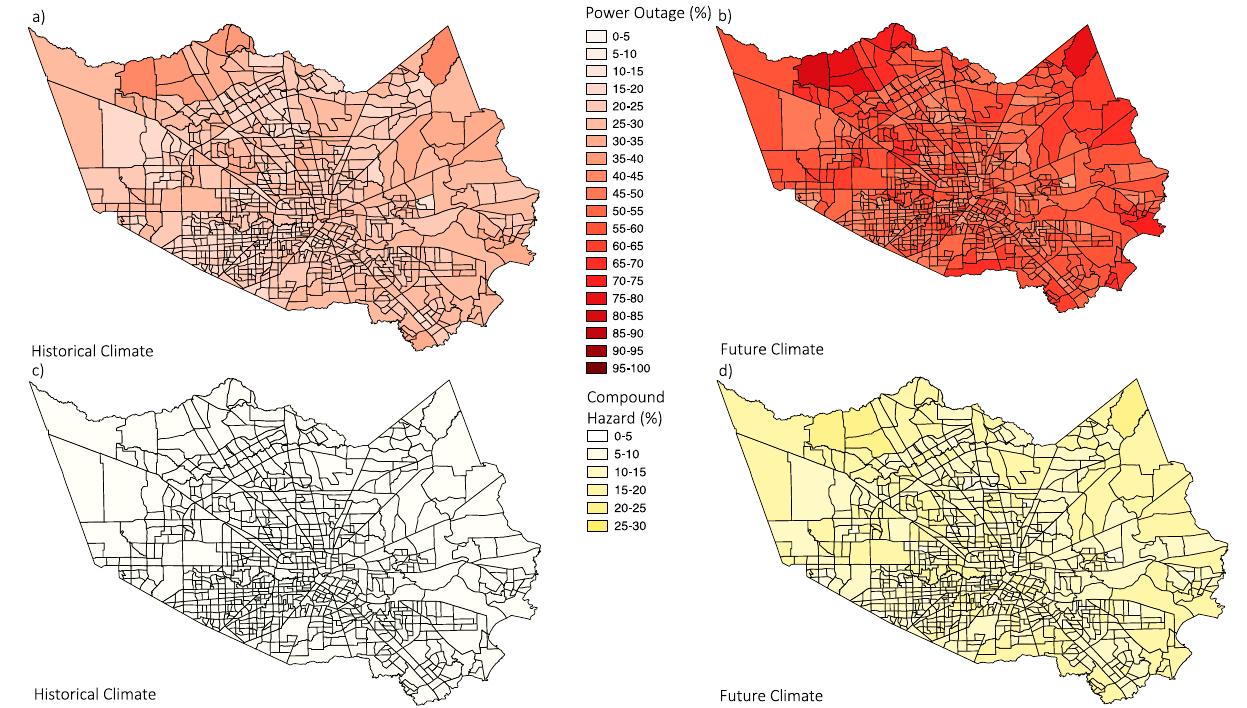
Fig. 4 | Spatial distribution of estimated blackout and compound hazard impact. Estimated percentage of residents facing at least one longer-than-5-day